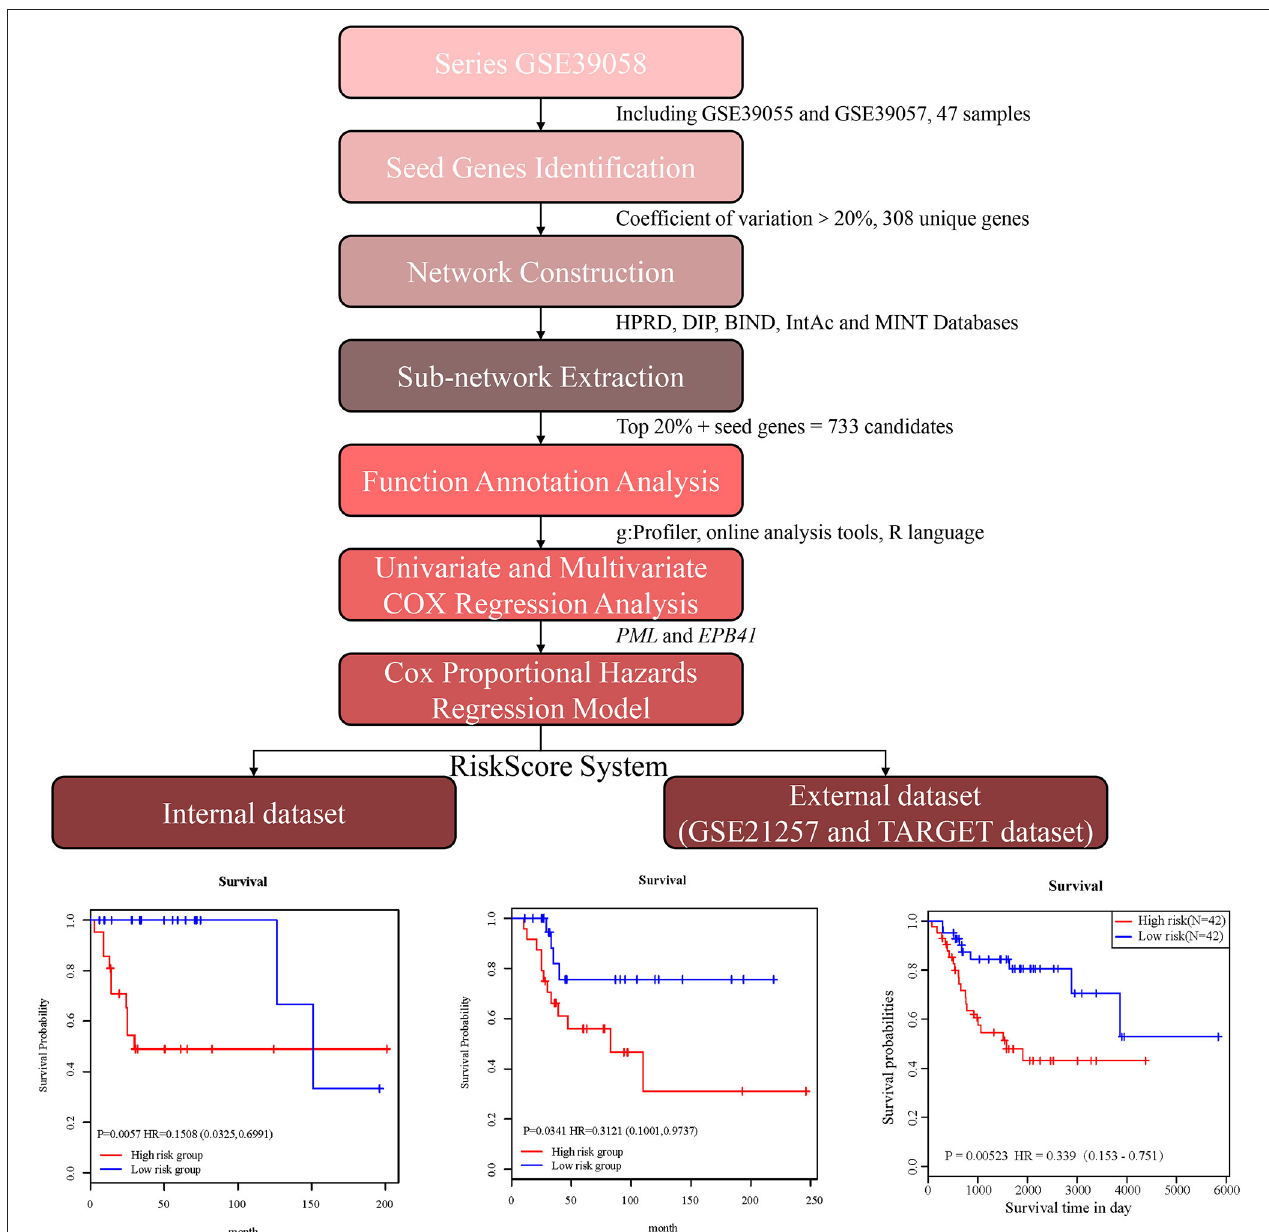
FIGURE 1 | Schematic diagram for a multi-step strategy to identify 2-gene signature for the prognostic prediction of osteosarcoma.